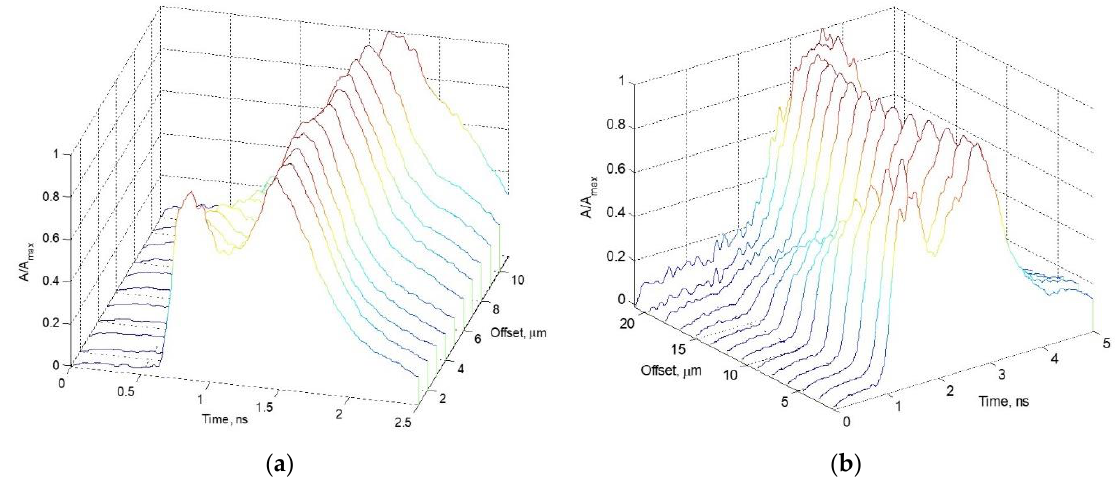
Figure 21. DMD map of combined link, containing 500 m length of MMF Cat. OM2 (Tx) and 20 m length of chiral ESSR-MOF (Rx): ( a ) 10 revolutions per meter; ( b ) 66 revolutions per meter.